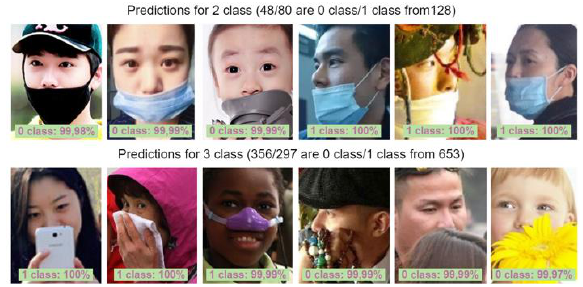
Figure 2. Predictions for 2 and 3 classes.